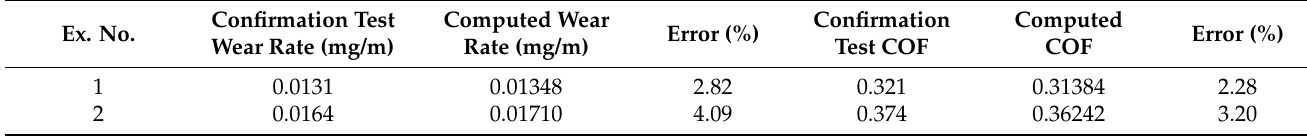
Table 9. Comparison of confirmation test values and predicted